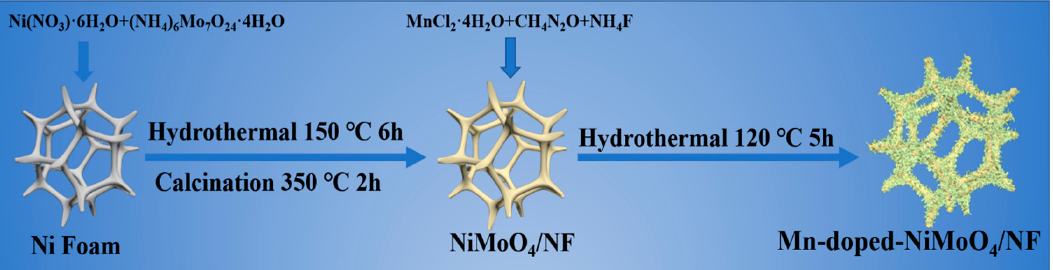
Figure 1. Schematic diagram of the synthesis process of Mn-doped-NiMoO 4 /NF. The physical phase composition and crystal structure of NiMoO 4 /NF precursors and Mn-doped-NiMoO 4 /NF were studied by XRD, as shown in Figure 2a,b. Except for the dif- fraction peaks at 44.5°, 51.8°, and 76.4°, which perfectly matched the standard PDF card of metallic nickel foam (JCPDS 04-0850), the other diffraction peaks perfectly matched the standard PDF cards of NiMoO 4 ·xH 2 O (JCPDS 13-0128) and NiMoO 4 (JCPDS 86-0361 and JCPDS 45-0142) (as shown in Figure 2a) [40]. There was a significant decrease in the lattice parameters of the NiMoO 4 /NF precursors with the doping of Mn as the reaction time in- creased from 3 h to 8 h, as shown in Figure 2b. The diffraction peak was slightly shifted to the right, which can be attributed to the fact that the radius of the Mn 2+ ion is smaller than that of the Ni 2+ ion. In addition, a diffraction peak attributed to MnO (JCPDS 04-0326) could be observed around 26.6°, corresponding to a crystal plane of (1 2 0). Figure 2. XRD patterns of ( a ) the precursors NiMoO 4 /NF and ( b ) Mn-doped-NiMoO 4 /NF with dif- ferent reaction times (3 h, 5 h, 8 h). 3.2. Raman Analysis To gain insights into the structural composition of the material, the electrocatalyst was further characterized by Raman spectroscopy. As shown in Figure 3a, the Mn-doped- NiMoO 4 /NF possessed characteristic peaks attributed to NiMoO 4 at positions 356 cm − 2 , 827 cm − 2 , 872 cm − 2 , and 948 cm − 2 [41]. The band at 923 cm − 1 and 872 cm − 1 indicates the symmetric stretching and asymmetric stretching bonds of the Mo–O bonds, respectively. Another band at 356 cm − 1 was assigned to the bending vibration of the O–Mo–O units [42,43]. In contrast to NiMoO 4 /NF, the broad Raman band located in the range of 440 cm − 2 to 600 cm − 2 may be attributed to the Mn–O bonding vibrational mode of the oxides of amorphous Mn (Figure 3b). The above conclusions are consistent with the XRD results.